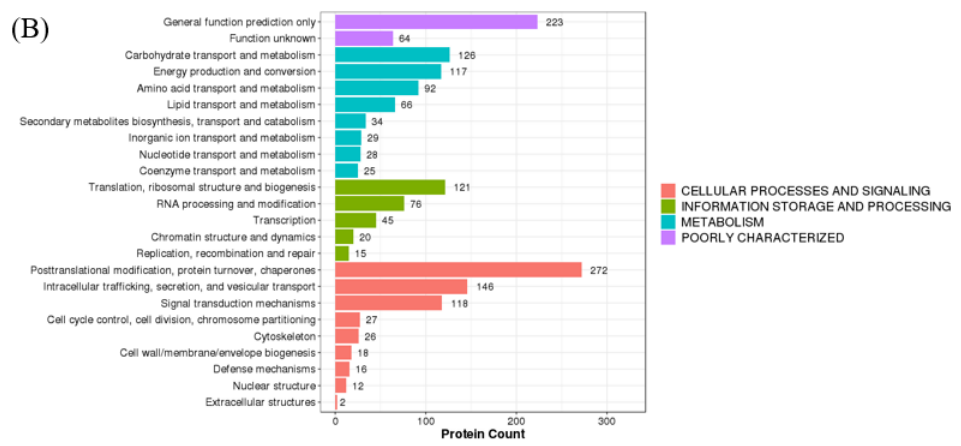
Figure 2. ( A ) Gene ontology (GO) term enrichment for coconut derived proteins. ( B ) Bar chart of the Eukaryotic orthologous group (KOG) analysis.